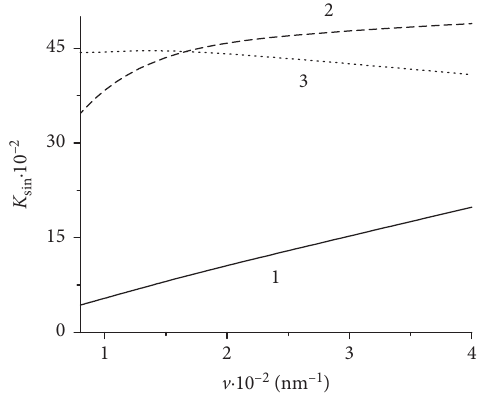
Figure 3: Contrast of the evanescent field K quartz surface profile depending on the spatial frequency ] of the profile at different heights of the protrusions h : 5 nm (curve 1), 50nm (curve 2), and 150nm (curve